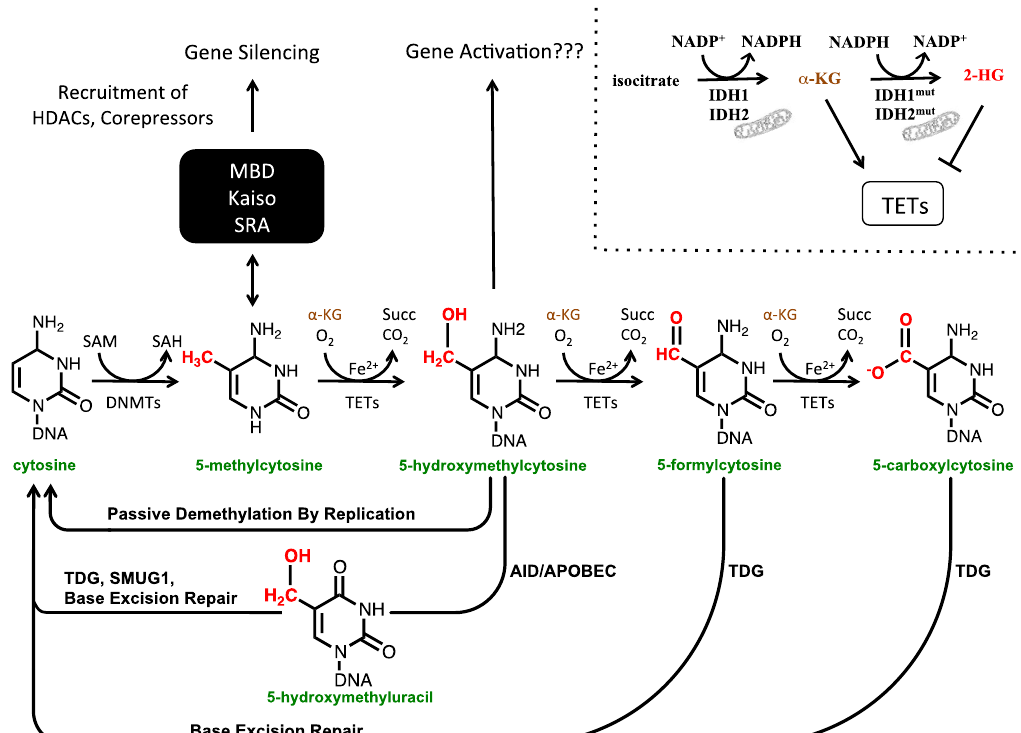
Figure 1. The cytosine modification pathway. DNMT1, DNMT3A, and DNMT3B methylate cytosine to form 5-methylcytosine (5-mC) using S-adenosyl methionine (SAM) as a methyl donor. 5-methylcytosine can then be oxidized to 5-hydroxymethylcytosine (5-hmC), 5-formylcytosine (5-fC), and 5-carboxylcytosine (5-caC) by the TET dioxygenases, which use α-ketoglutarate (α-KG), molecular oxygen, and iron as cofactors. Isocitrate dehydrogenase (IDH) enzymes produce α-KG by oxidation of isocitrate. IDH2 is found in the mitochondria. Mutated IDH proteins are capable of generating 2-hydroxyglutarate (2-HG), which inhibits the TET dioxygenases (top right). 5-mC at gene promoters represses gene transcription by binding methyl binding domain (MBD) proteins (MeCP2, MBD1, MBD2, MBD3, MBD4), Kaiso family proteins (Kaiso, ZBTB4, ZBTB38), and